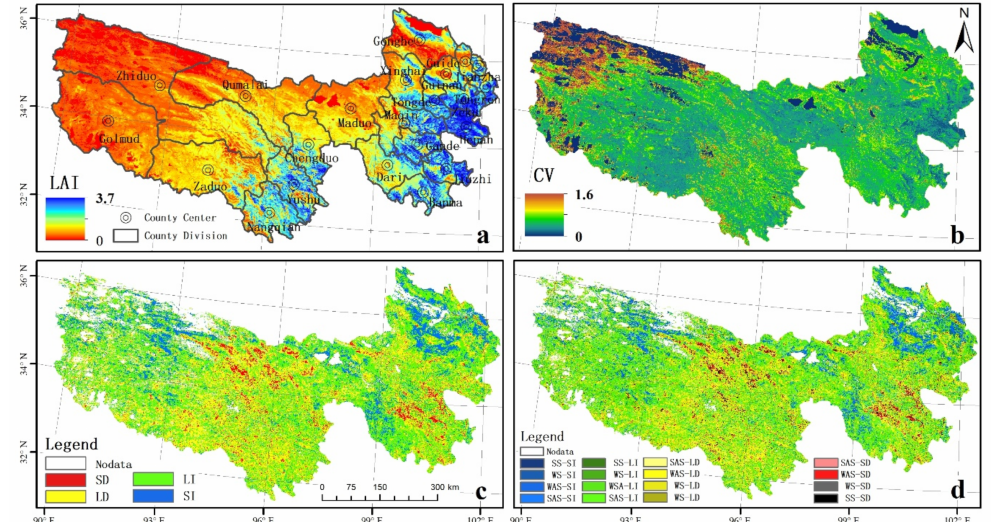
Figure 5. Spatial distributions and spatial variations in time series LAI changes for the growing seasons in the TRSR from 2000 to 2017: ( a ) multi-year average values, ( b ) stability, ( c ) trend, and ( d ) sustainability. SD represents significant degradation, LI represents lightly improvement, LD repre- sents lightly degradation, SI represents significant improvement, SS represents strongly sustainable, WS represents weakly sustainable, SAS represents strongly anti-sustainable, and WAS represents weakly